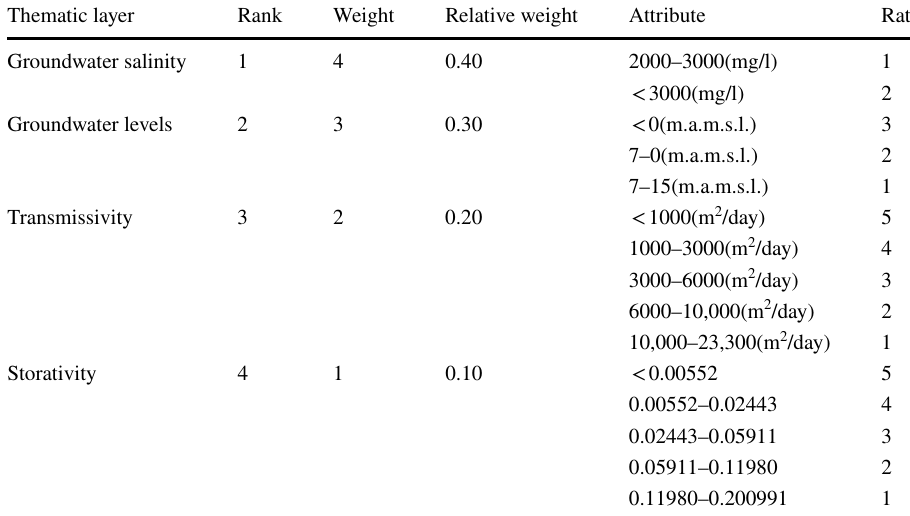
Table 2 Categorizing the contributing criteria and their rank, weight, and rate affecting the groundwater assessment